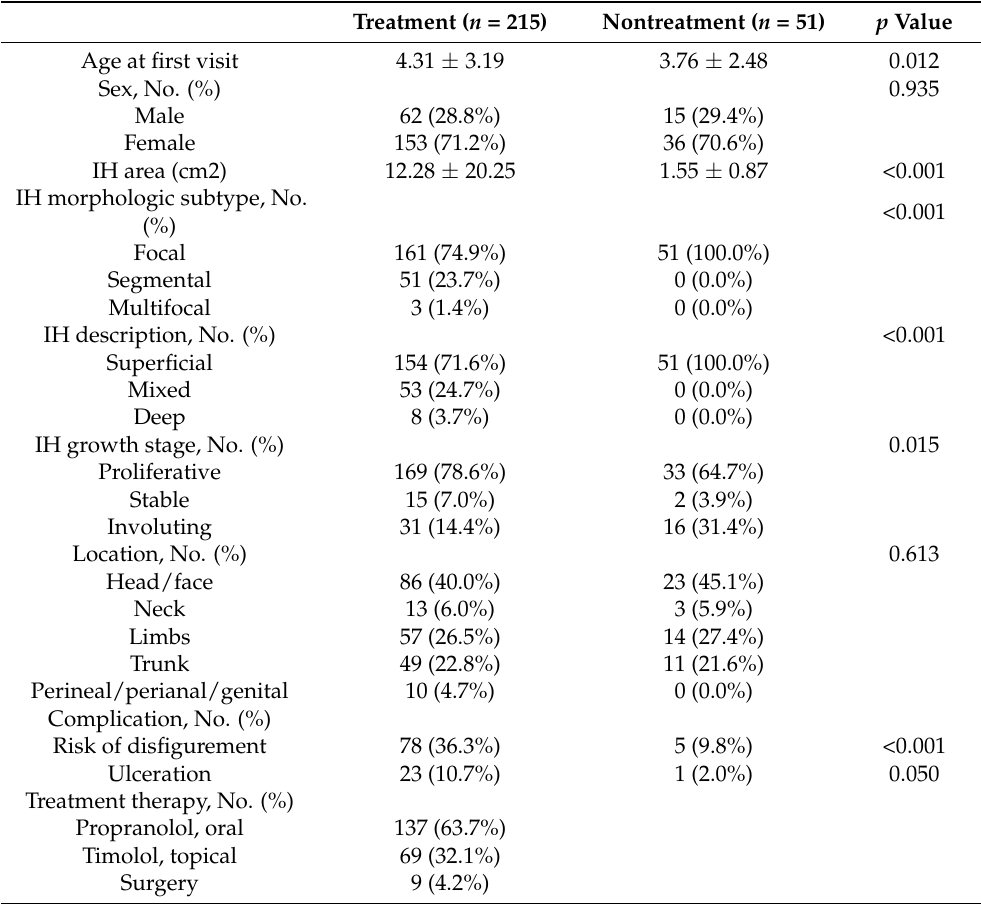
Table 1. Clinical characteristics of infantile hemangioma (IH) patients between the treatment group and the nontreatment